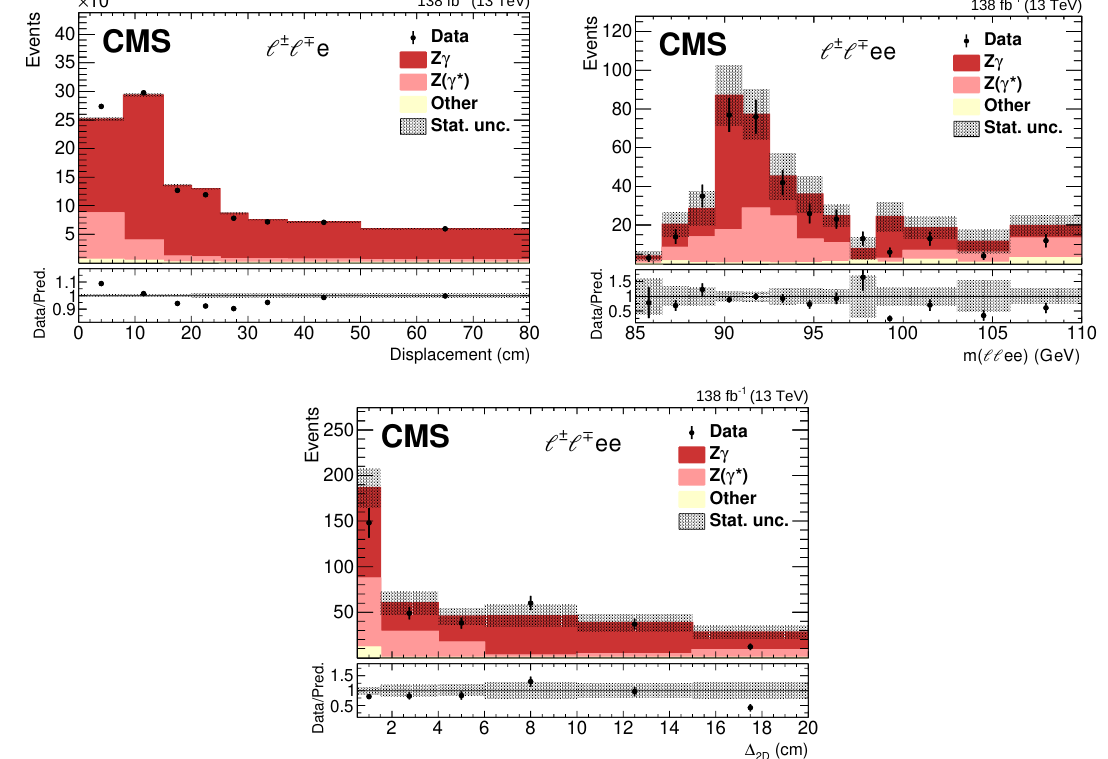
Figure 4 . Comparison between the observed number of events in data and simulation for converted photons. Events are selected in the final states with three (upper left) or four (upper right, lower) leptons, with one (or two) of the leptons identified as displaced electron(s). The distributions are shown for the displaced electron displacement d (upper left) and reconstructed invariant mass of four leptons (upper right). Additionally, the ∆ variable is presented (lower). The simulated events 2D correspond to the processes with external conversions, Z g ; internally converted photons, Z( g ∗ ) ; and other processes with the production of vector bosons and top quarks. In the distributions for the four-lepton final state (upper right, lower), the scale factor derived from the distribution of d in three-lepton events (upper left) has been applied to the simulated events. The hashed band represents the statistical uncertainty in the simulation. The lower panels indicate the ratio between data and